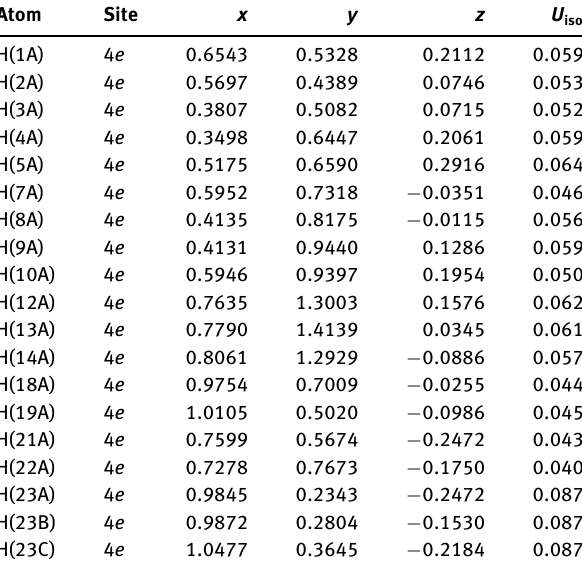
Table 2: Fractional atomic coordinates and isotropic or equivalent isotropic displacement parameters (Å 2